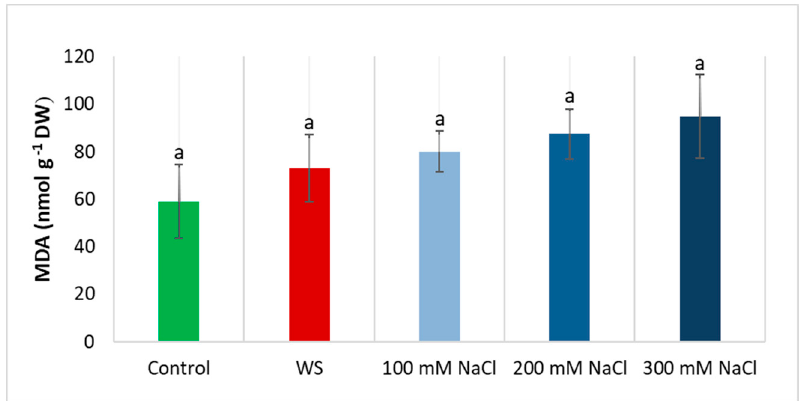
Figure 6. Malondialdehyde (MDA) needle levels in one-year-old A. alba seedlings after 30 days of growth in the presence of the indicated NaCl concentrations or subjected to water deficit stress (WS). Bars represent means ± SE ( n = 7). Different letters above the bars indicate significant differences between treatments, according to Tukey’s test ( α = 0.05).